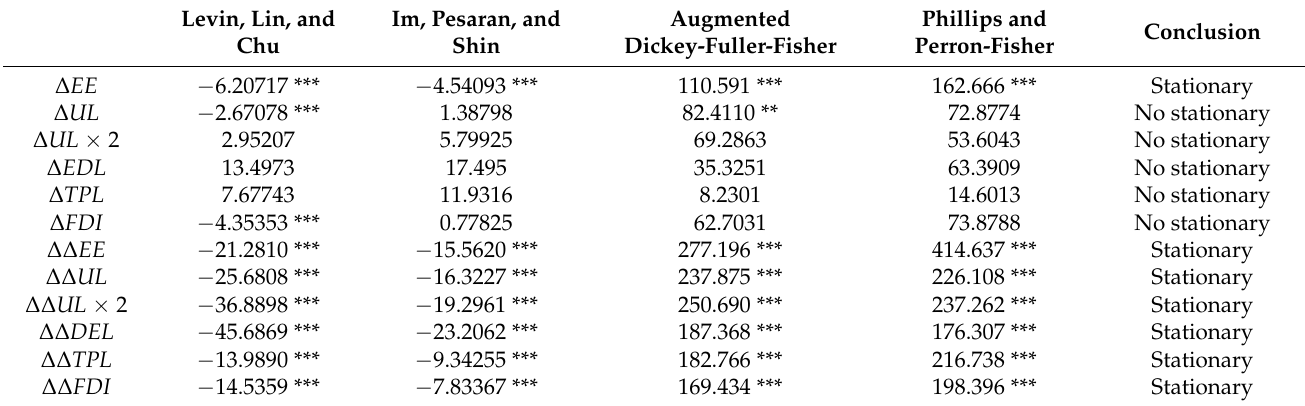
Table 4. The results of unit root test.